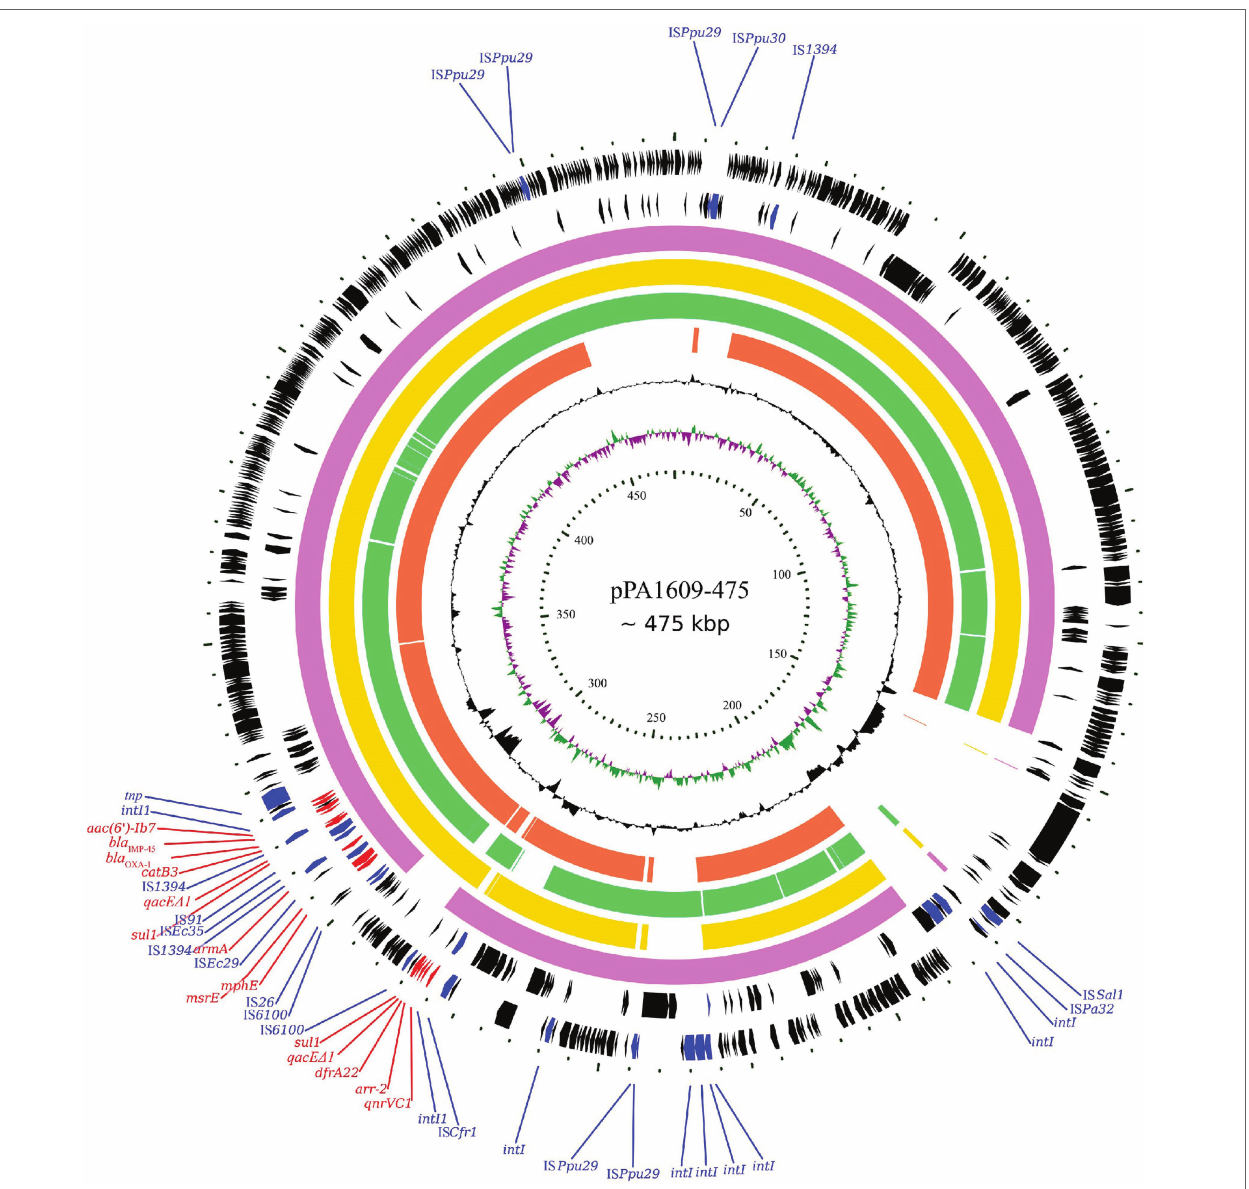
FIGURE 2 | Complete genome sequence of the pPA1609-475 plasmid and comparative genomic analysis of the pPA1609-475 plasmid sequence with other homologous sequences. The circles (from innermost to outermost) represent (i) the scale in kb; (ii) the cumulative GC skew of pPA1609-475; (iii) the GC content of pPA1609-475; (iv) four homologous plasmids pA681-IMP (MF344570.1 from Pseudomonas aeruginosa ), pPAG5 (CP045003.1 from P . aeruginosa ), pBM413 (CP016215.1 from P . aeruginosa ) and pSY153-MDR (KY883660.1 from P. putida), respectively; (v) the annotated coding sequences of pPA1609-475 with selected genes indicated according to the gene function: antimicrobial resistance genes in red arrows, transposase genes and IS elements in blue